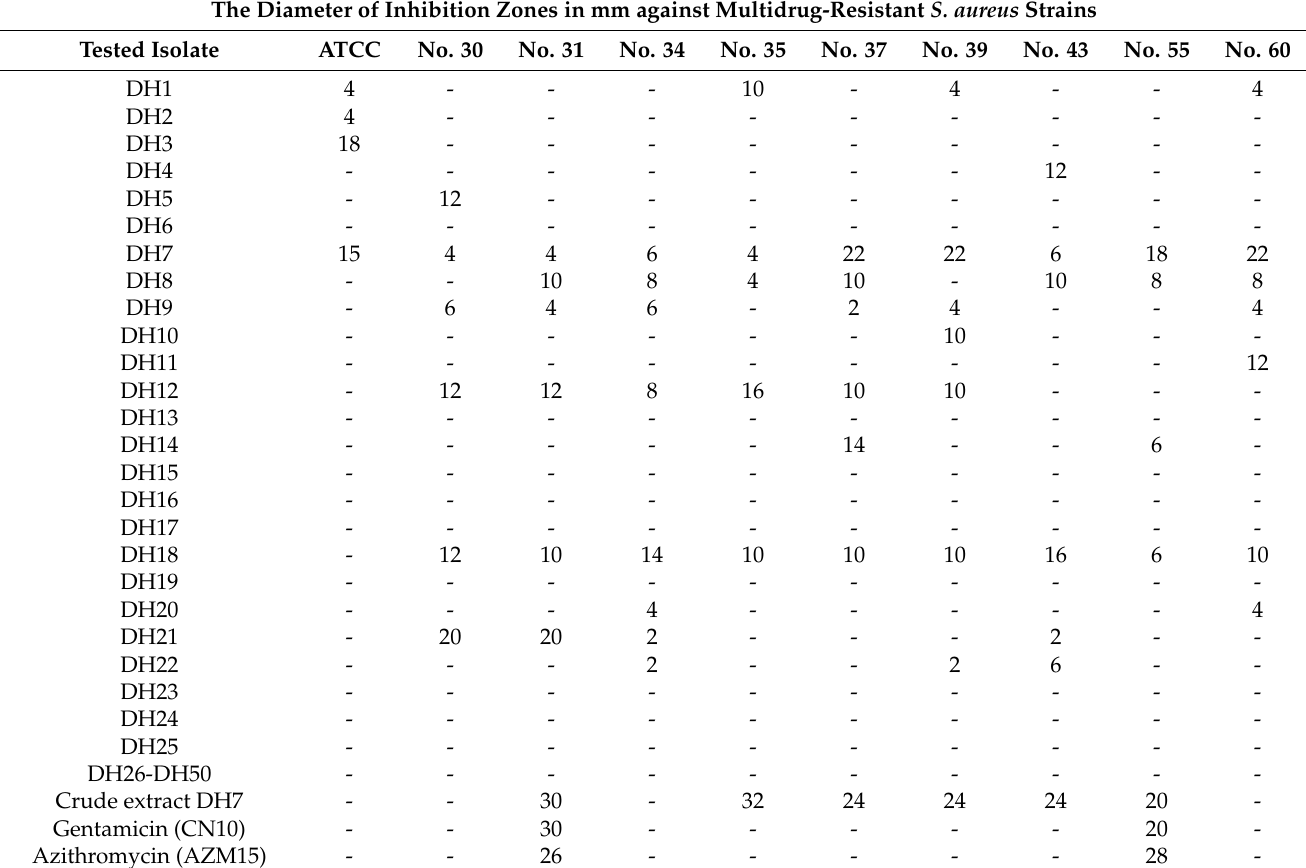
Table 1. The antimicrobial potential of Actinobacteria isolates against multidrug-resistant S. aureus strains. The Diameter of Inhibition Zones in mm against Multidrug-resistant S. aureus Strains Tested Isolate ATCC